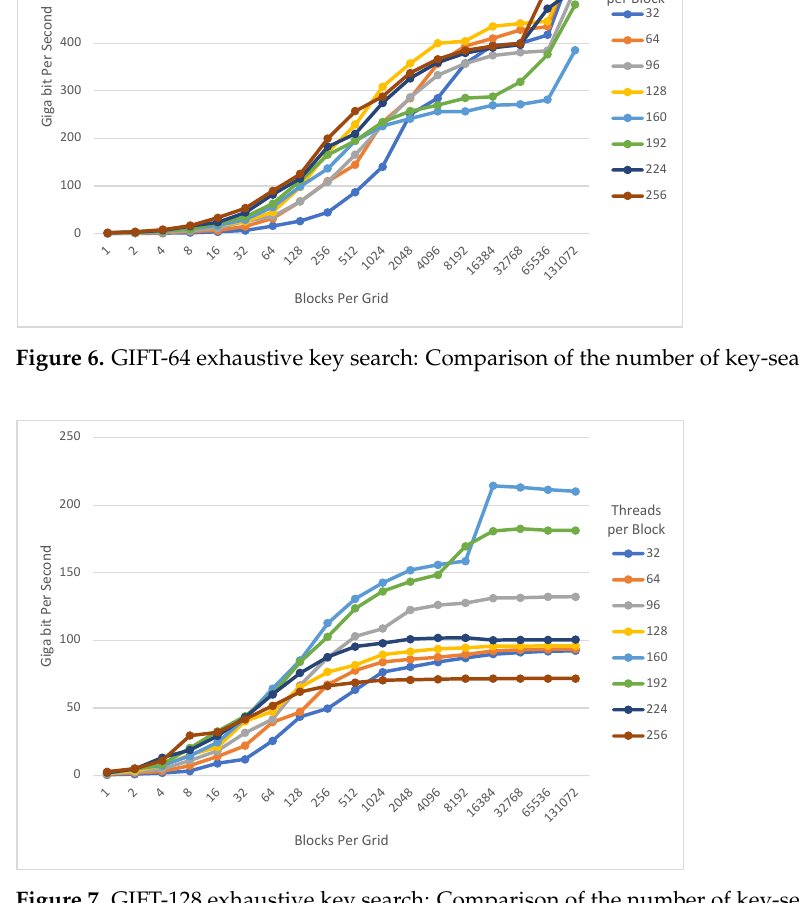
Figure 7. GIFT-128 exhaustive key search: Comparison of the number of key-search per